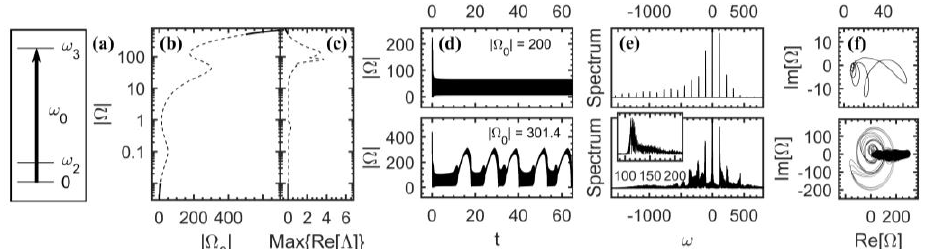
Fig. 1. (а) – Scheme of QE excitation. (b) – The monolayer’s steady-state response. (с) – The real part of the major Lyapunov exponent. Solid (dashed) parts indicates stable (unstable) of the solution. (d), (e) and (f) – Respectively, dynamics, Fourier spectra and phase space trajectories of the system calculated for the field magnitudes |Ω 0 | shown in panel (d). Parameters of calculations are: Δ 21 = 100, γ R = 100, Δ L = 1000, γ 21 = 0.01. All quantities are given in units of γ 31 . caption. As is seen, |Ω| turns out to be a multi-valued function of |Ω 0 The stability of different parts of the solution has been explored analyzing the Lyapunov’s exponents Λ k (k = 1,2…8). The maximal real part of {Λ k }, Max{Re[Λ]}, is plotted in panel (c). Plots (d), (e) and (f) display, respectively, dynamics, Fourier spectra and phase space maps of the signals obtained for two values of |Ω 0 | shown in the plots. For |Ω 0 | = 200γ 31 , the dynamics demonstrates self- oscillations, while for |Ω 0 | = 302.4γ 31 – (quasi)chaotic behaviour.